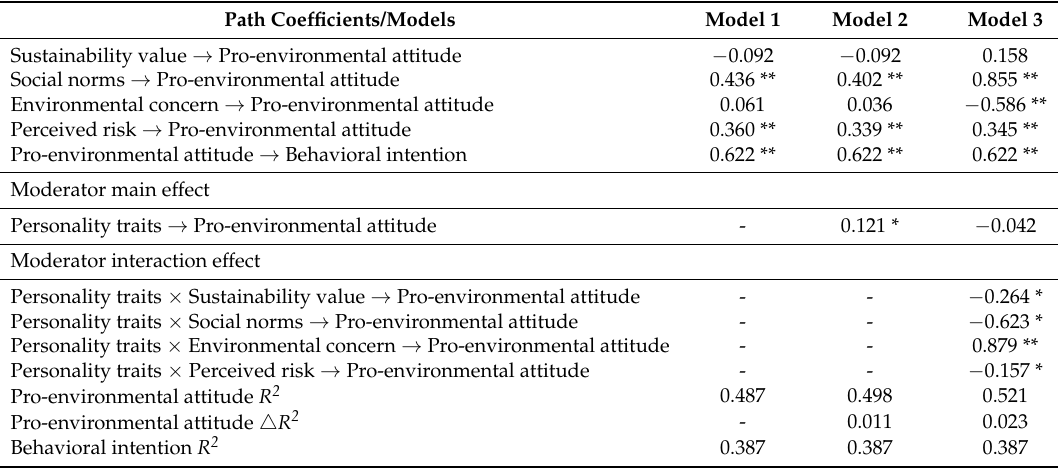
Table 3. Path coefficients of the research